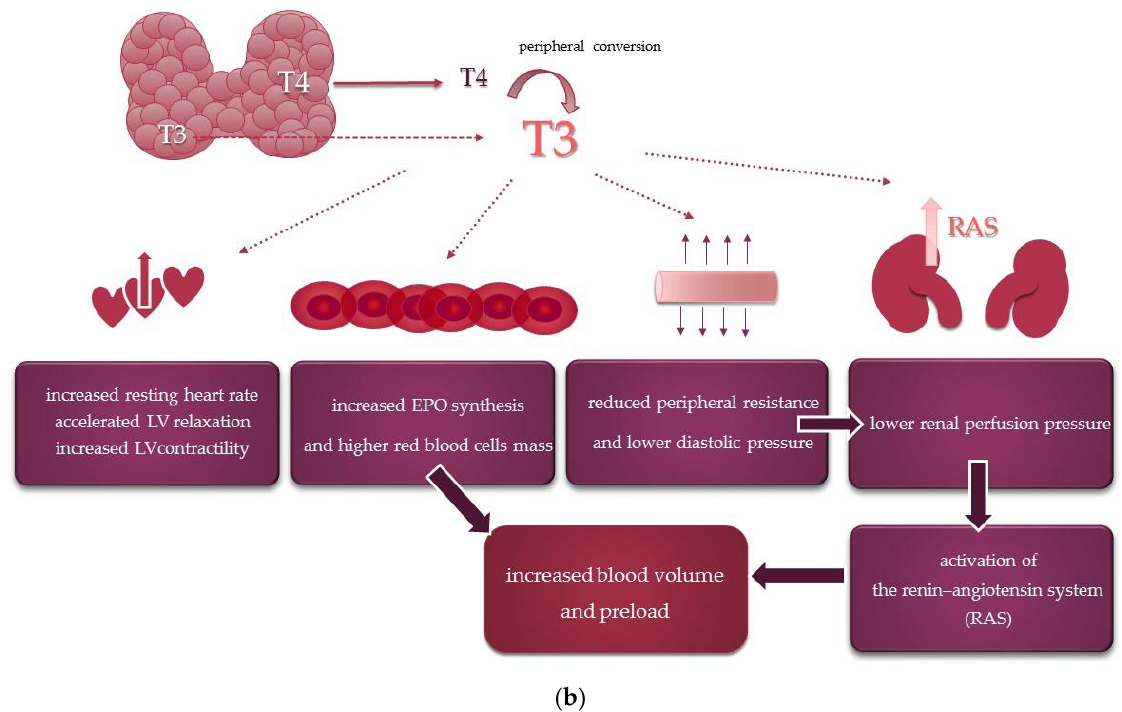
Figure 1. Effects of TH on the cardiovascular system at the cellular level and at organ level: ( a ) Cellular genomic mechanisms include T3 binding to thyroid hormone receptor (THR) in the nucleus of cardiomyocytes, which regulates transcription of various genes by binding to thyroid hormone response elements (TREs). Nongenomic cellular pathways involve modulation of ion channels in the cell membrane of cardiomyocytes, Na + /K + -ATPase, Na + /Ca 2+ exchanger, MAP kinase, PI3-kinase, and AKT-dependent signaling pathways, mitochondriogenesis and endothelial NO generation; ( b ) TH modulate cardiac inotropy, lusitropy and chronotropy, systemic vascular resistance and preload with a consequent increase in cardiac output. TH—thyroid hormones, T3—triiodothyronine, THR—thyroid hormone receptor, TREs—thyroid hormone response elements, SERCA—sarcoplasmic reticulum calcium-activated ATPase, MAP kinase—mitogen-activated protein kinase, PI3-kinase—phosphatidylinositol 3 kinase, AKT—protein kinase B, NO—nitric oxide, EPO—erythropoietin., LV— left ventricular.